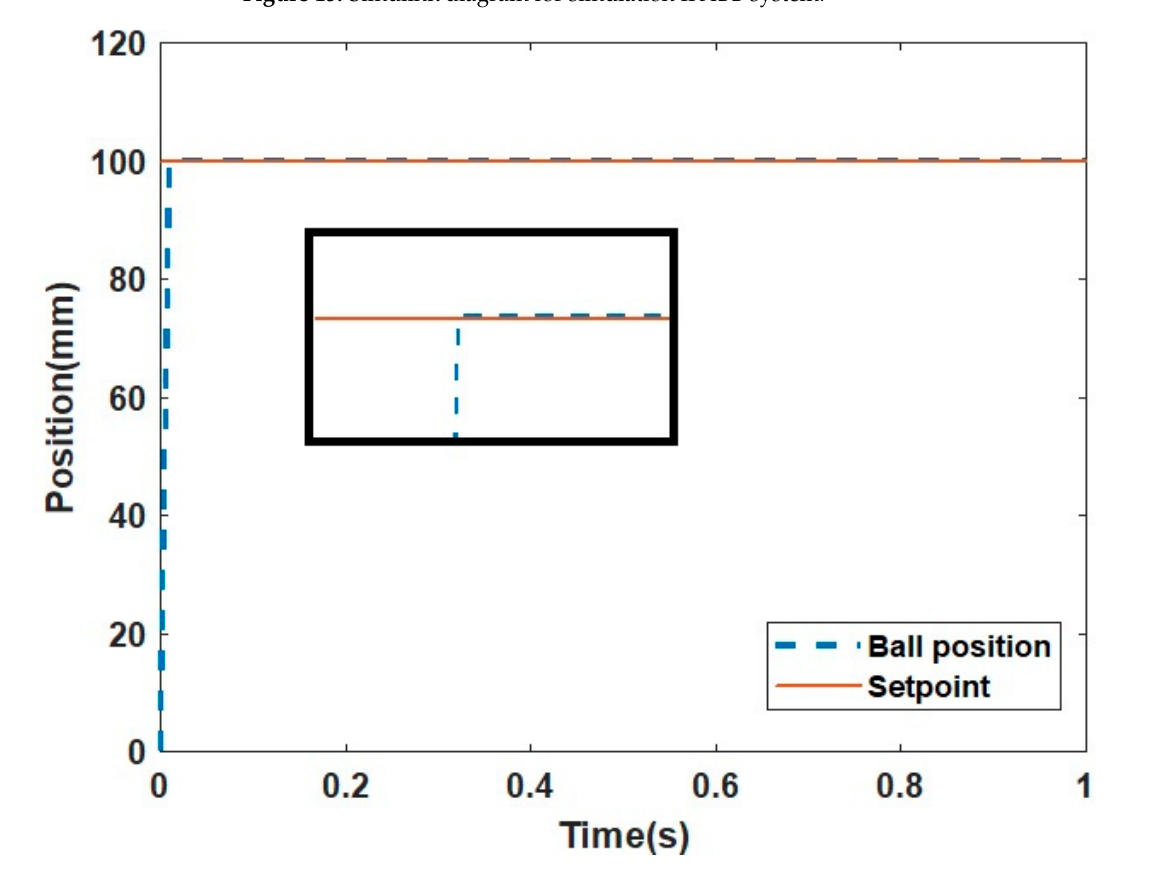
Figure 16. The responses of CFOPID and PID controllers.